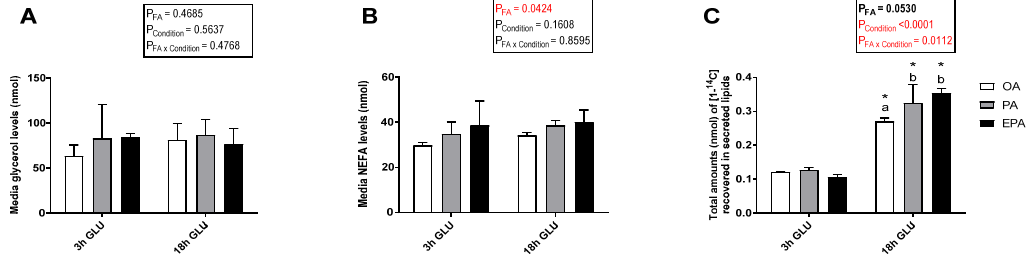
Figure 6. Total glycerol ( A ), non-esterified free fatty acids (NEFA) ( B ), and [1- 14 C] from radiolabelled PA recovered in secreted lipids ( C ) in the media from mature Atlantic salmon adipocytes incubated with oleic, palmitic, or eicosapentaenoic acid for 72 h and serum-deprived in the presence of glucagon thereafter for 3 (3 h GLU) and 18 h (18 h GLU). Data are shown as mean ± SEM ( n = 4 for glycerol and NEFA data, and n = 3 for radiolabeled lipids secreted data). Results are compared by two-way ANOVA using the fatty acid tested (OA, PA, and EPA) and the experimental condition (3 h GLU and 18 h GLU) as factors. Lowercase letters indicate significant di ff erences between fatty acids ( p < 0.05; Tukey’s post hoc test). Asterisks (*) indicate significant di ff erences between conditions ( p < 0.05; Sidak’s test). OA = oleic acid, PA = palmitic acid, and EPA = eicosapentaenoic